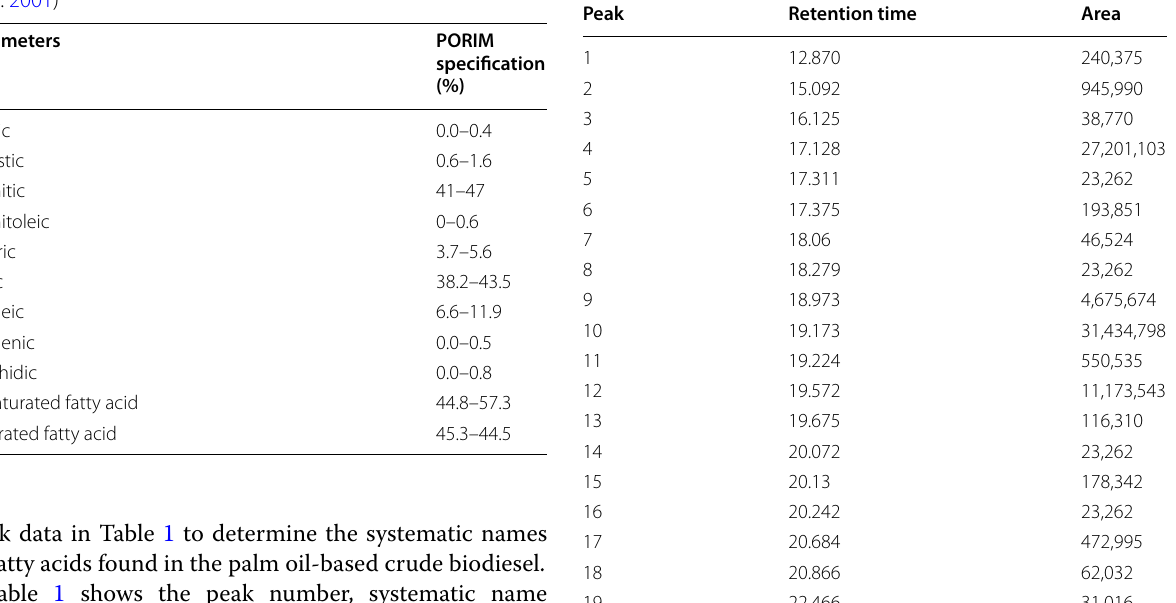
Table 3 GC–MS peak